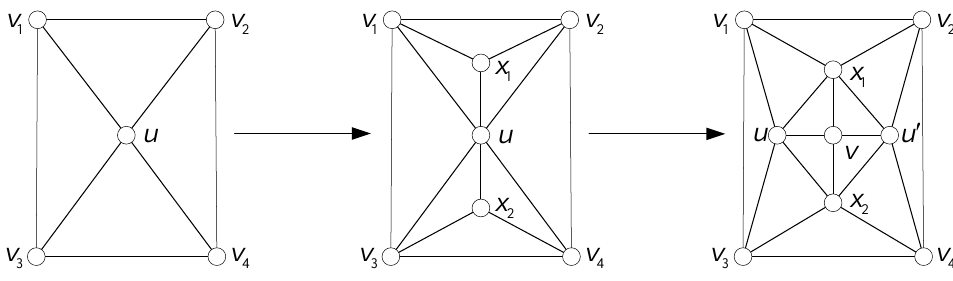
Figure 4. The dumbbell